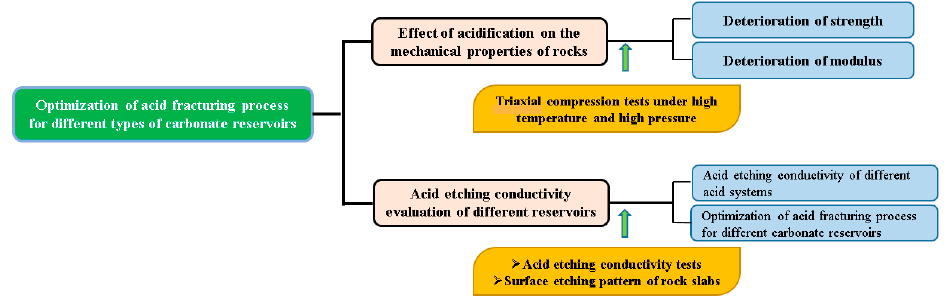
Figure 2. The flowchart of this